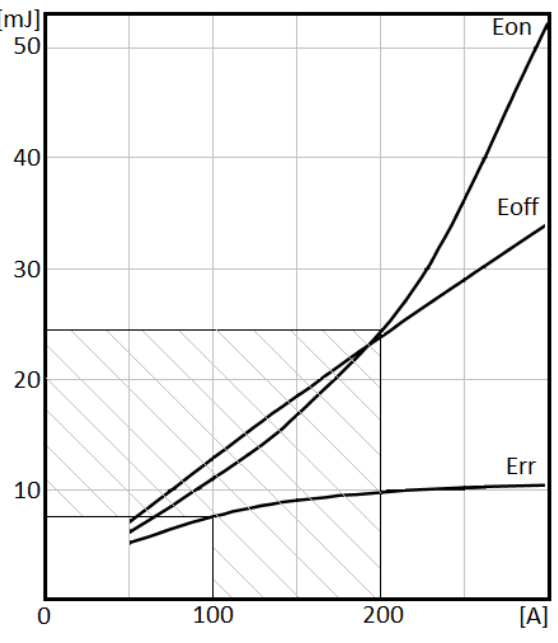
Figure 6. Accumulated energies E ON , E of f , E rr